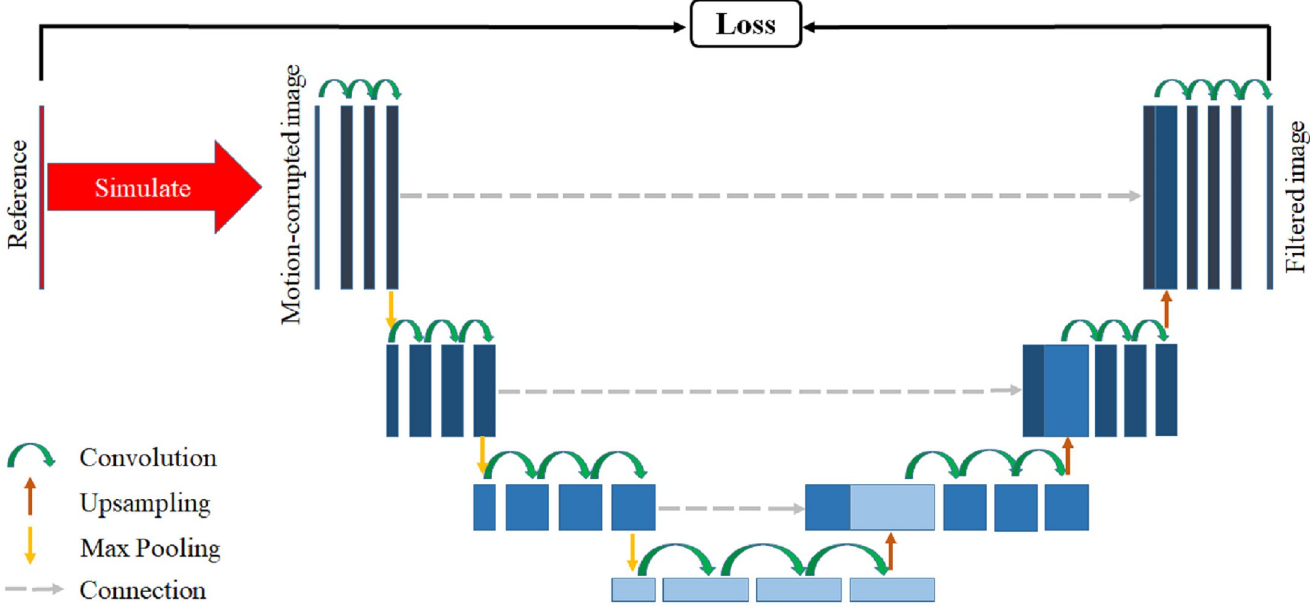
Fig 3. The architecture of the convolutional neural network (CNN) used to filter motion artifacts. The motion-corrupted images and the corresponding reference images were normalized before being used as the inputs of the network. Motion artifacts were alleviated in the output of the network, I filtered .